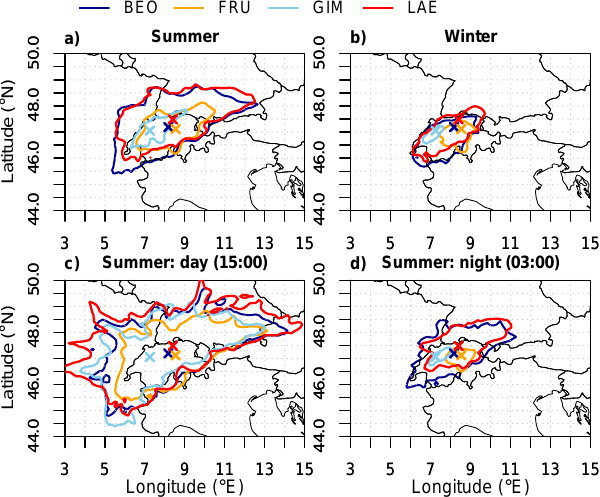
Figure 12. Area of surface influence (Eq. 5) defined as the iso- line at the site-dependent value τ s50 encompassing 50% of the to- tal mean surface sensitivities. Lines are color coded according to measurement site – Beromünster: dark blue, Früebüel: orange, Gim- miz: light blue, Lägern-Hochwacht: red. (a) Summer (June–August, 2013), (b) winter (December 2013–February 2014), and (c) and (d) summer (June–August 2013) in the afternoon (15:00UTC) and at nighttime (03:00UTC), respectively. Local time is central Euro- pean time (CET or UTC +